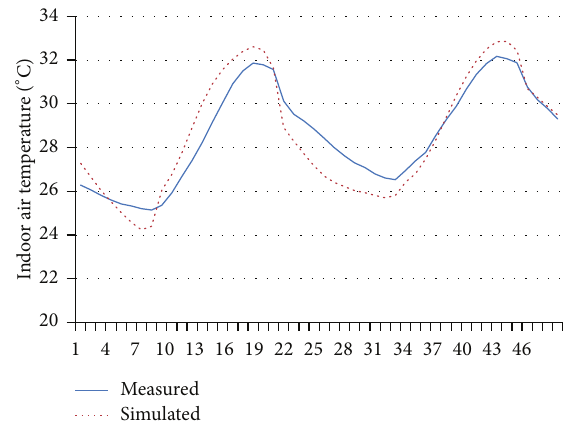
Figure 6: Measured versus simulated indoor air temperatures.